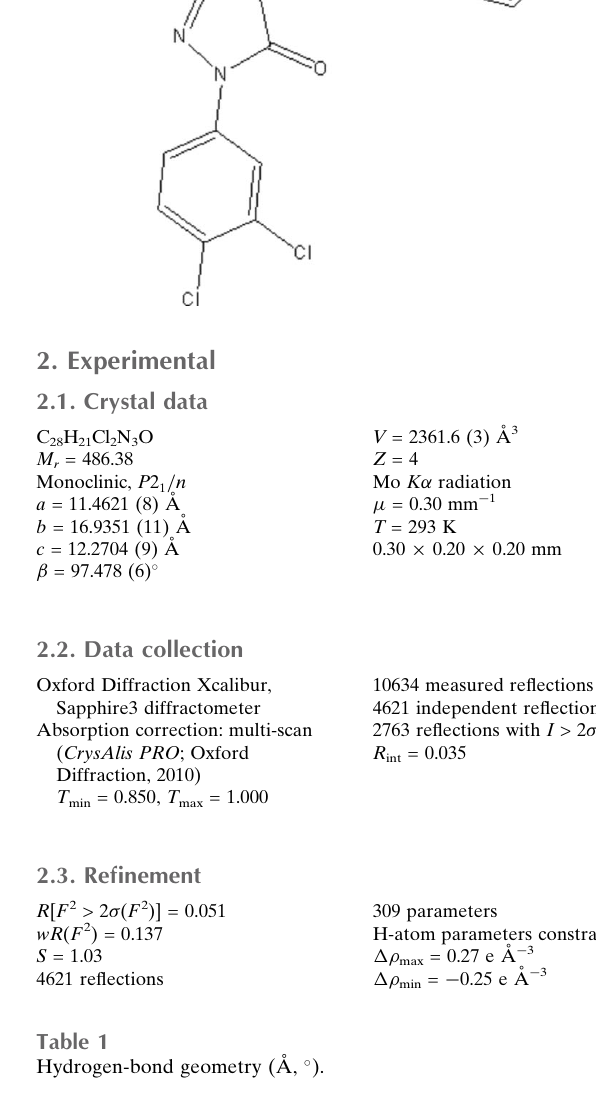
Hydrogen-bond geometry (A˚ , (cid:2)